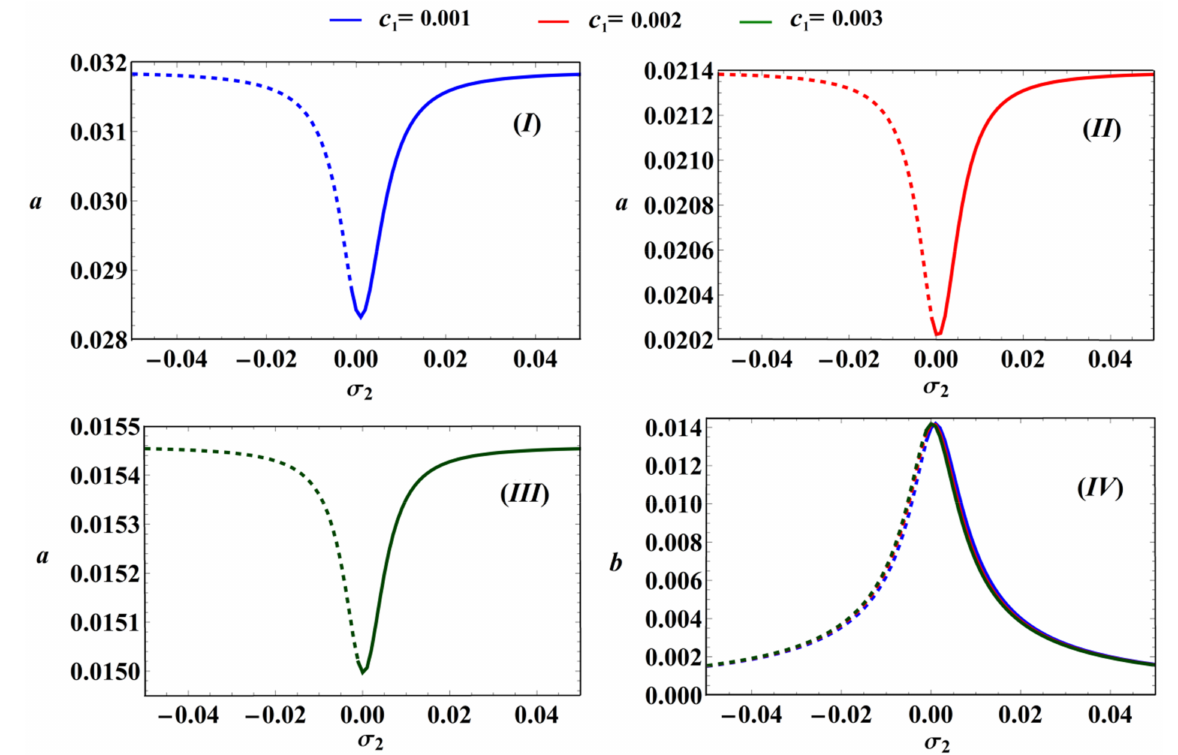
Figure 11. The frequency response at σ 1 = 0, W = 0.448, and c 2 = 0.011 of: a ( σ 2 ) when ( I ) c 1 = 0.001, ( II ) c 1 = 0.002, ( III ) c 1 = 0.003, and ( IV ) for b ( σ 2 ) .